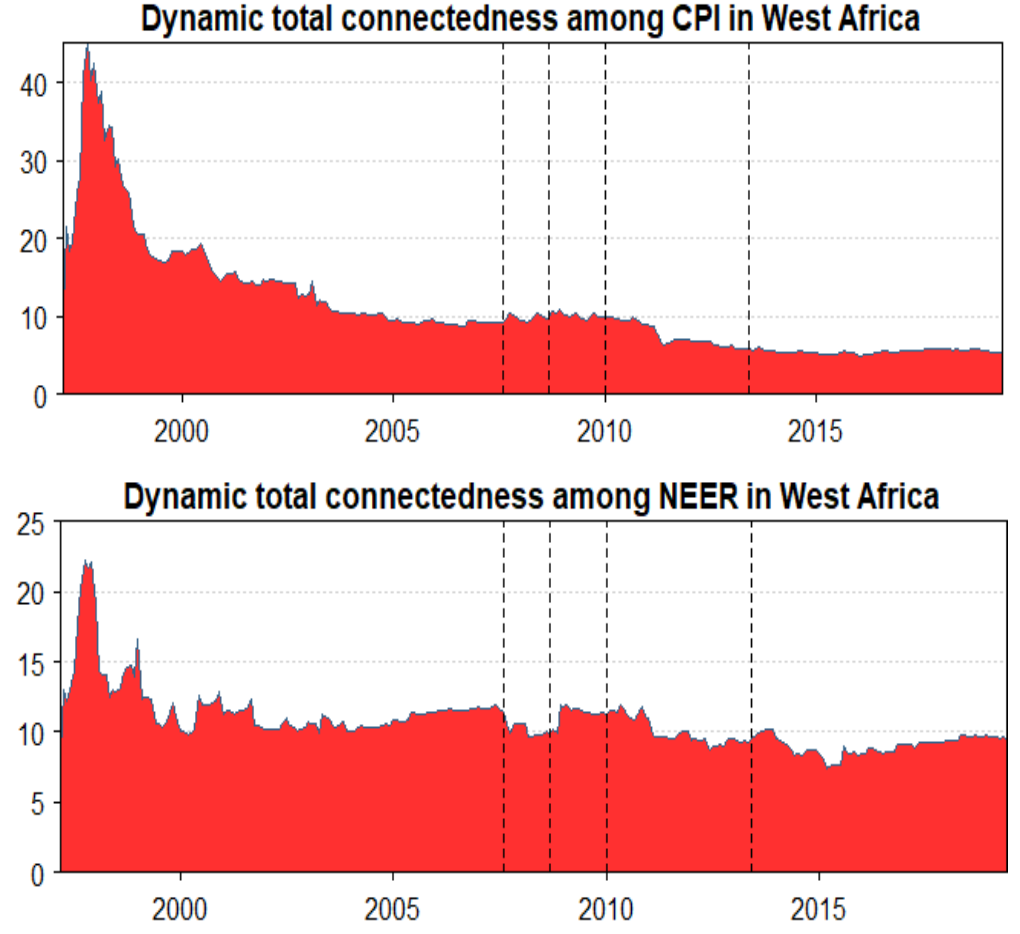
Figure 6. Dynamic total connectedness among country-level macroeconomic indicators in West Africa in the midst of external shocks.